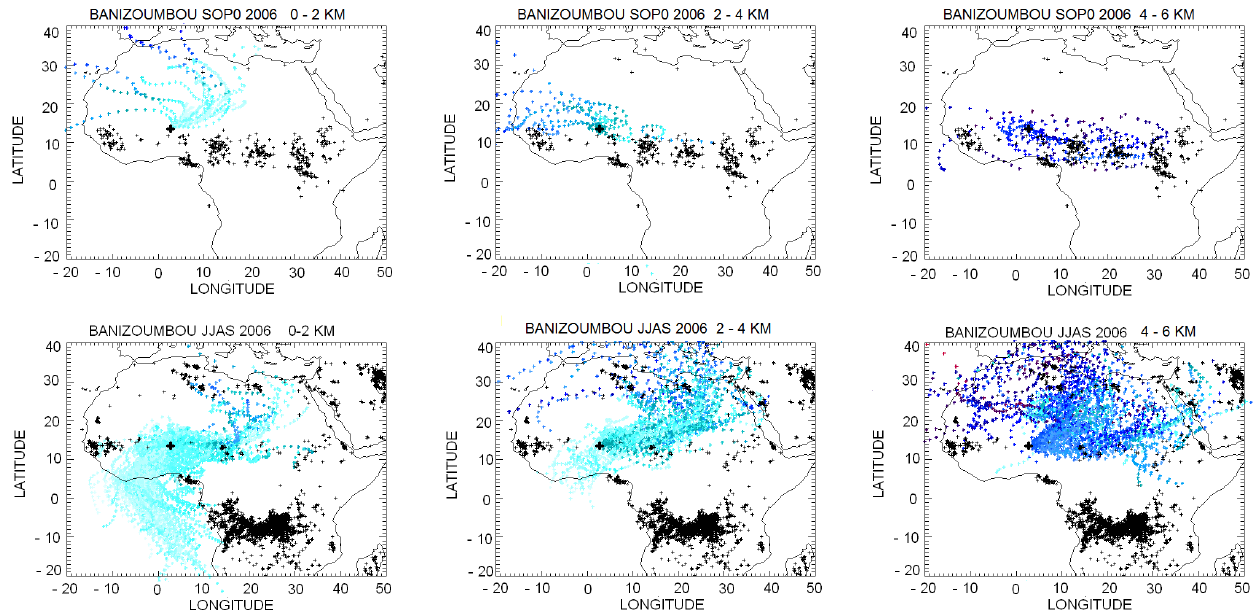
Fig. 2. Aeronet 7 day back -trajectories (blue dots) arriving at the Banizoumbou site between 0–2km (left), 2–4km (middle), 4–6km (right) along with a biomass burning emission map (black cross) for the period January-February 2006 (upper row) and June–September 2006 (lower row).